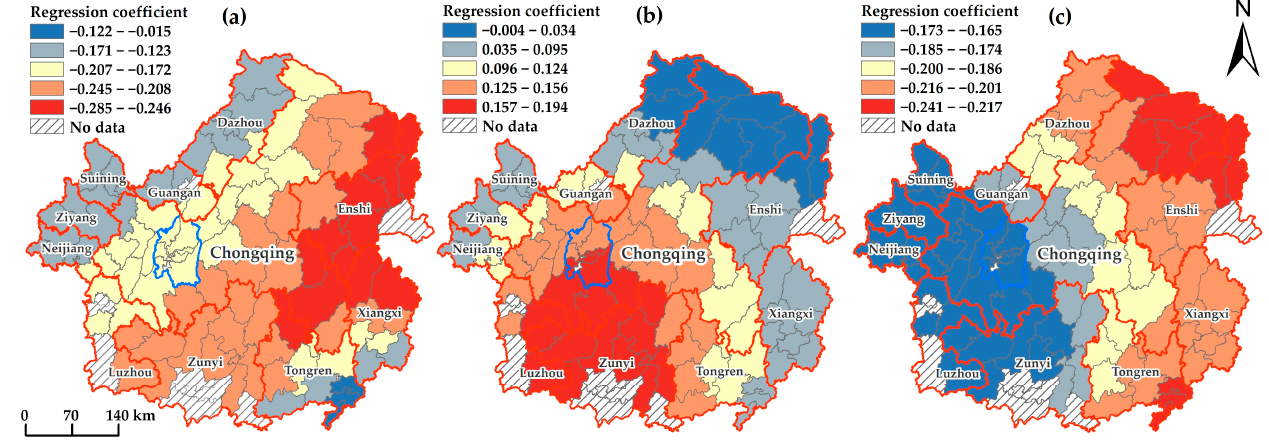
Figure 6. Spatial distribution of estimated parameters of the GWR model. ( a ) Regression coefficient of farmland mean slope; ( b ) regression coefficient of GDP; ( c ) regression coefficient of farmland supply ‒ demand